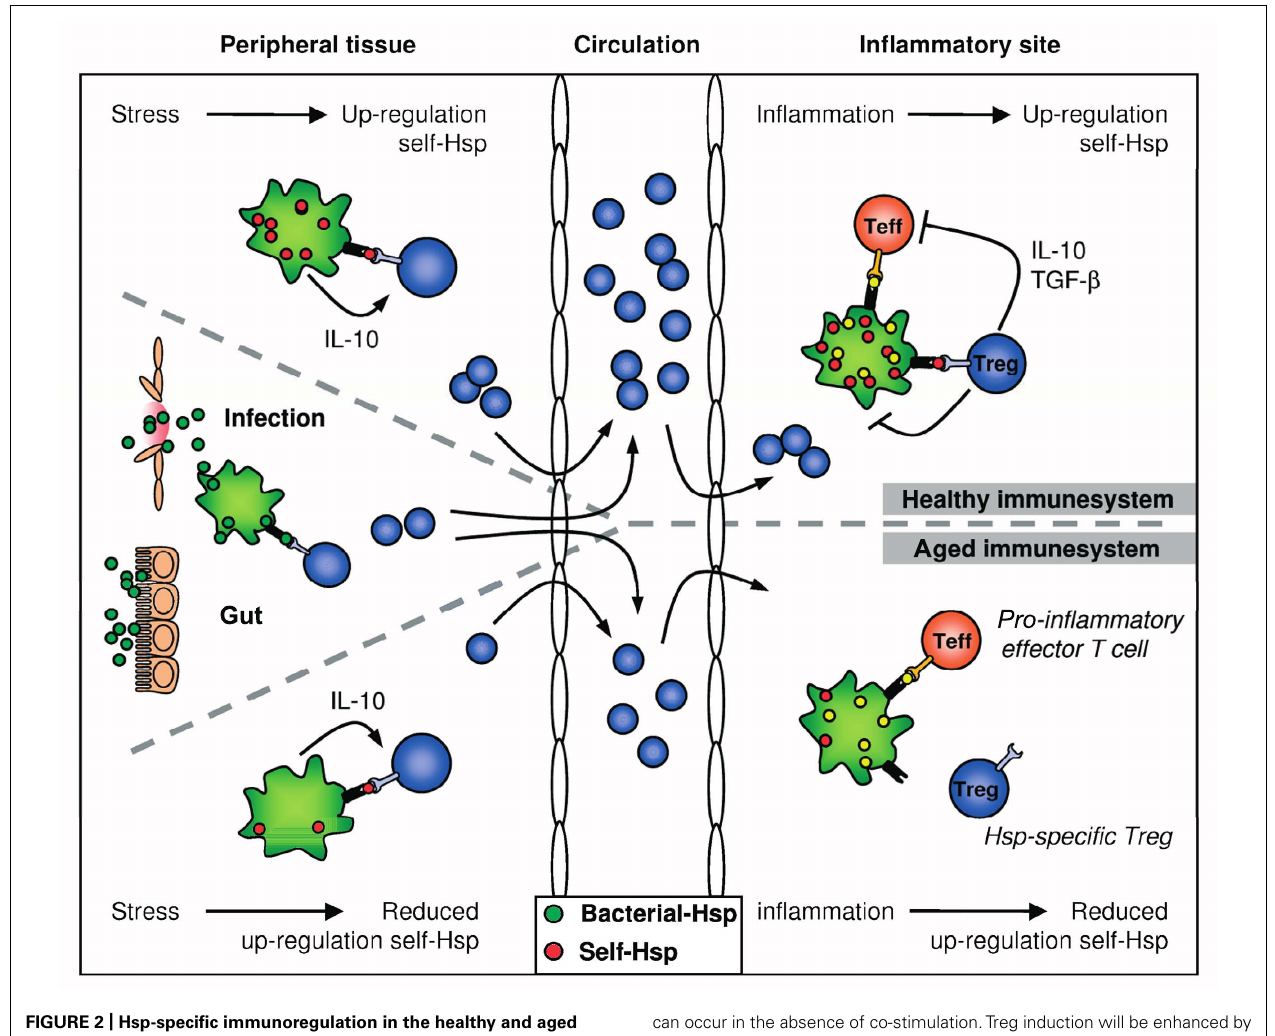
FIGURE 2 | Hsp-specific immunoregulation in the healthy and aged immune system. Self-Hsp-specificT cells reside in the circulation after escape from central tolerance in the thymus. Since Hsp are highly conserved, these self-Hsp-specificT cells can cross-recognize bacterial-Hsp.ThisT cell population can be expanded after exposure to bacterial-Hsp at mucosal surfaces like the gut or during infection. At mucosal surfaces, theseT cells will be directed toward a regulatory phenotype through mechanisms of mucosal tolerance. In addition,Treg induction and maintenance will be promoted by stress-induced Hsp expression in peripheral tissues, because up-regulation of self-Hsp and presentation of Hsp peptides by MHC class II